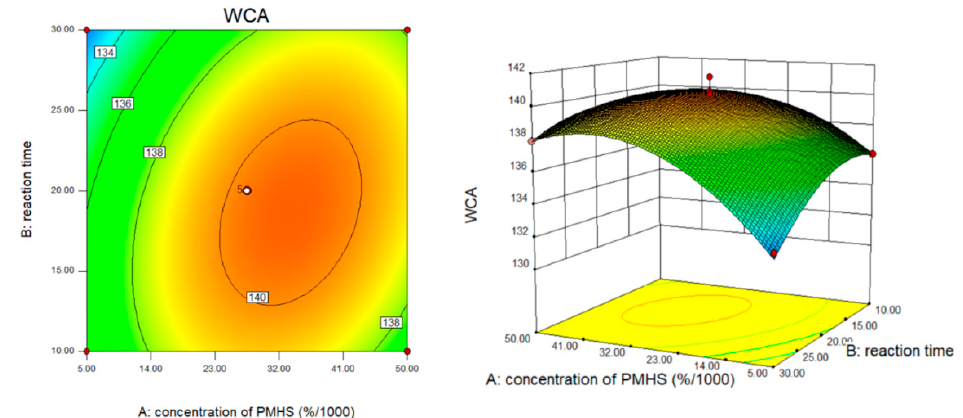
Figure 4. The effect of PMHS concentration and reaction time.